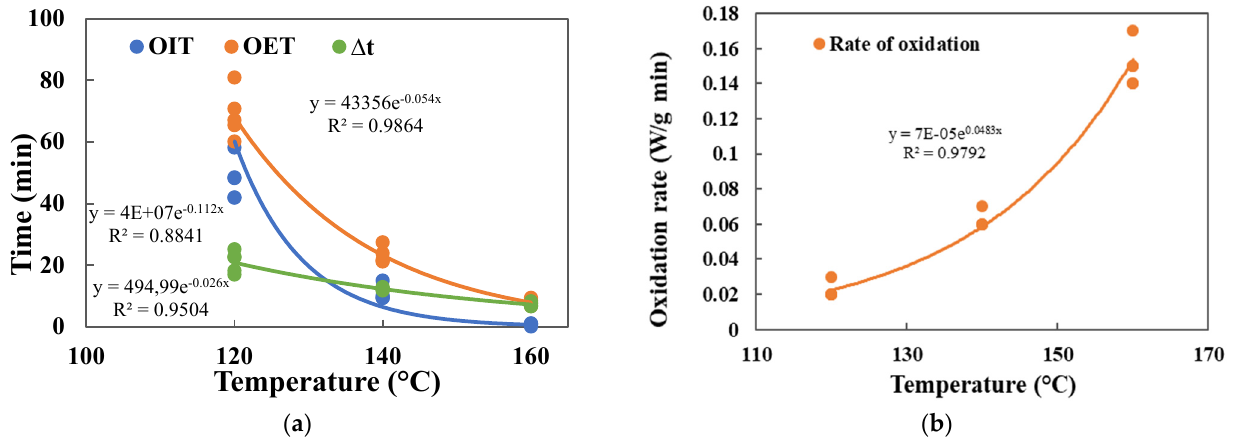
Figure 3. Relationship between temperatures and parameters of DSC isothermal measurement for 120, 140, and 160 °C: ( A ) for OIT, OET, and oxidation duration ∆ t; ( B ) for rate of oxidation. On the other hand, other chemical compounds may also be important for the stability of hemp seed oil. Data presented in Table 4 show the samples’ stability determined using different conventional chemical methods. Peroxide values represent the presence of per- oxides and hydroperoxides (known as primary oxidation products), whence p-anisidine values shows the concentration of unsaturated aldehydes (detection at 350 nm absorption), which can express the secondary oxidation metabolites present in samples. Considering the primary oxidation condition, samples shows significant differences ( p ≤ 0.05) regardless of the freshness of the seeds, whence for secondary oxidation phenomena, the charac- teristics are opposite, thus pronouncing the overall freshness of the oil samples. Hence, oil sample HP_19C showed the highest stability simultaneously throughout all chemical measurements, which in turn has been supported by the results obtained from isothermal (OIT) and dynamic (T on ) parameters from DSC. A Different approach presented shows the simultaneous increase in primary and secondary oxidation products after roasting them in different temperatures [7] or during accelerated oxidation [18]. Alternative chemical anal- ysis to determine oxidative stability paved the results of conjugated dienoic and trienoic acid (%) values, and the ultraviolet absorption measured at wavelengths λ = 233 (K 233 ) and λ = 268 (K 268 ) presented for oil samples shows the primary and secondary oxidation products for both groups of oils. Although thIS data shows the notifiable presence of primary deterioration for all samples, it did not show any significant differences ( p > 0.05) between the seeds quality of stored and fresh-pressed oils. In order to establish which parameters are significantly correlated with DSC parameters, correlation analysis was carried out (Table 7). Significant positive correlation coefficients were obtained between DSC oxidation parameters and MUFA content (at a significant level of α = 0.05). The next significant correlation (negative) was found between OIT parameters and PUFA content. Strong, significant negative correlations were also found for AV with OIT and OET val- ues for 160 ◦ C (r = − 0.921 and r = − 0.724), as well as with color parameter a* for 160 ◦ C (r = − 0.959 and r = −